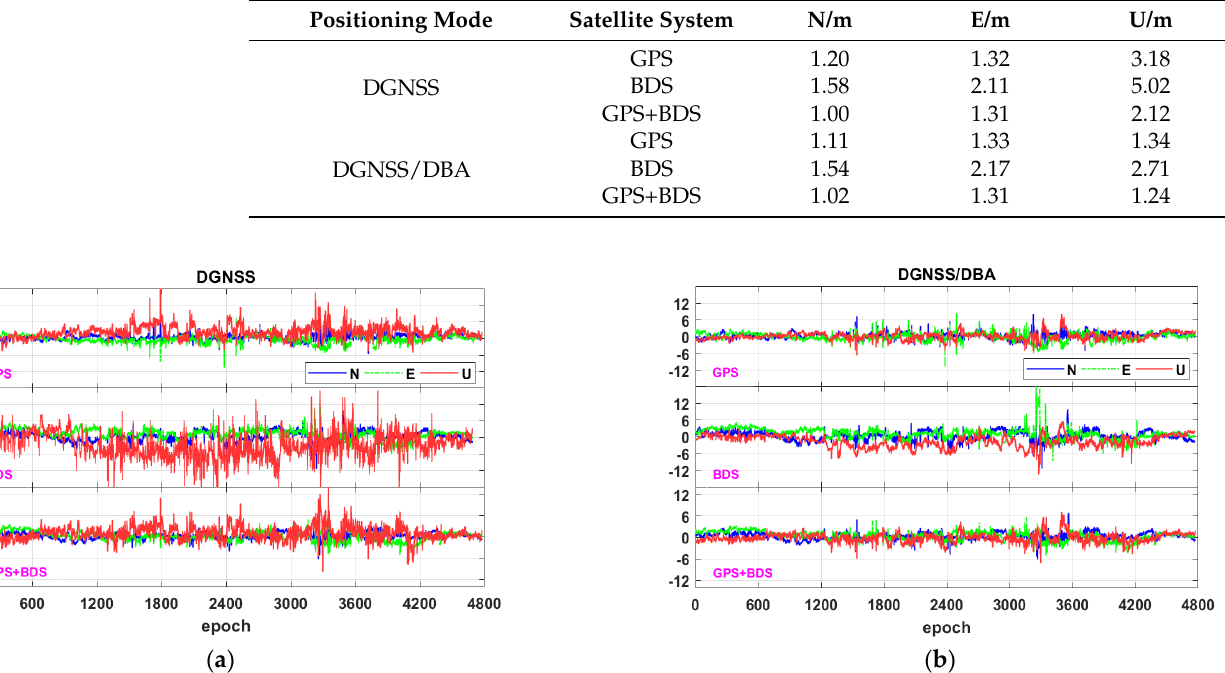
Figure 14. Comparison of the low-cost BMP280 barometer DBA altitude with the Trimble NET R9 reference altitude during the kinematic vehicle experimental in the open urban environment. The RMSE statistical results and deviation sequence in the N/E/U directions for both DGNSS and DGNSS/DBA modes are given in Table 6 and Figure 15, respectively. The RMSE values of single GPS and single BDS in the N/E/U directions were 1.20/1.32/3.18 m and 1.58/2.11/5.02 m for DGNSS mode, respectively. The GPS/DBA, BDS/DBA, and GPS+BDS/DBA modes improved the RMSE by 40% to 60% in the U direction and increased slightly in the N and E directions, and the DBA altitude showed a good constraint effect. Table 6. The RMSE of bias in the N/E/U directions for DGNSS and DGNSS/DBA modes during the kinematic vehicle experiment in the open urban environment.